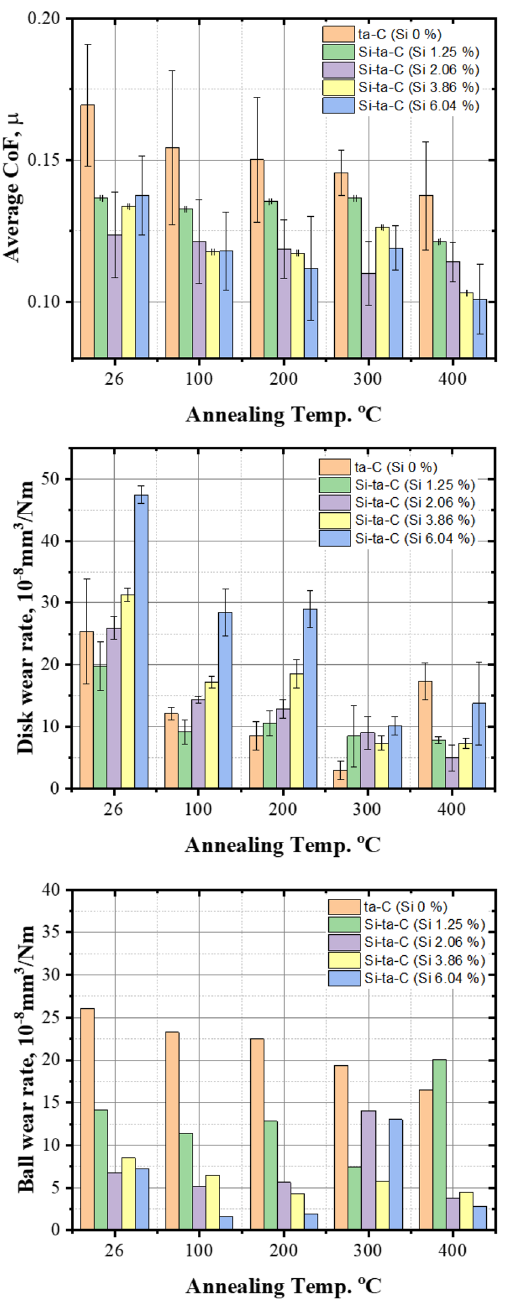
Figure 11. Average coefficient of friction (CoF), wear rate of the disk, and Si 3 N 4 ball wear rate of tetrahedral amorphous carbon (ta-C) and Si/SiC/ta-C composite (Si–ta-C) coatings before and after annealing at different temperatures (100–400 °C ) (data derived from analysis of the worn